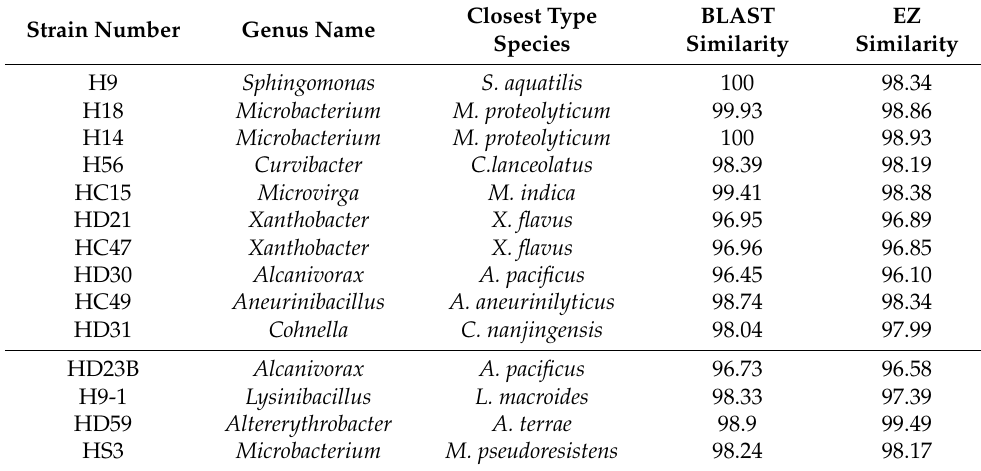
Table 4. Suspected bacteria new species isolated by